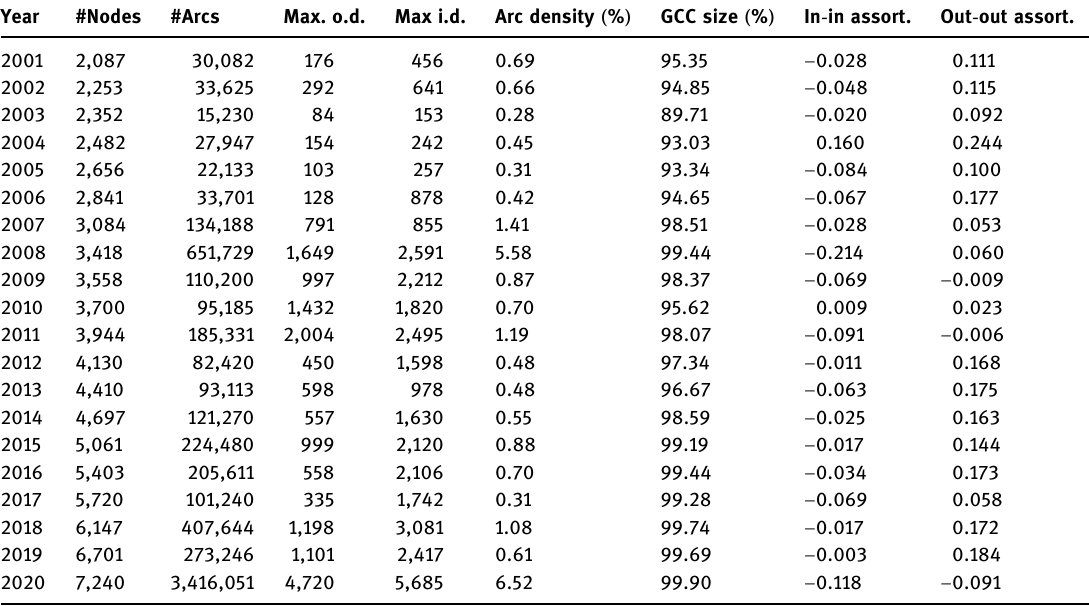
Table 2: Basic characteristics of networks corresponding to each time period Year #Nodes #Arcs